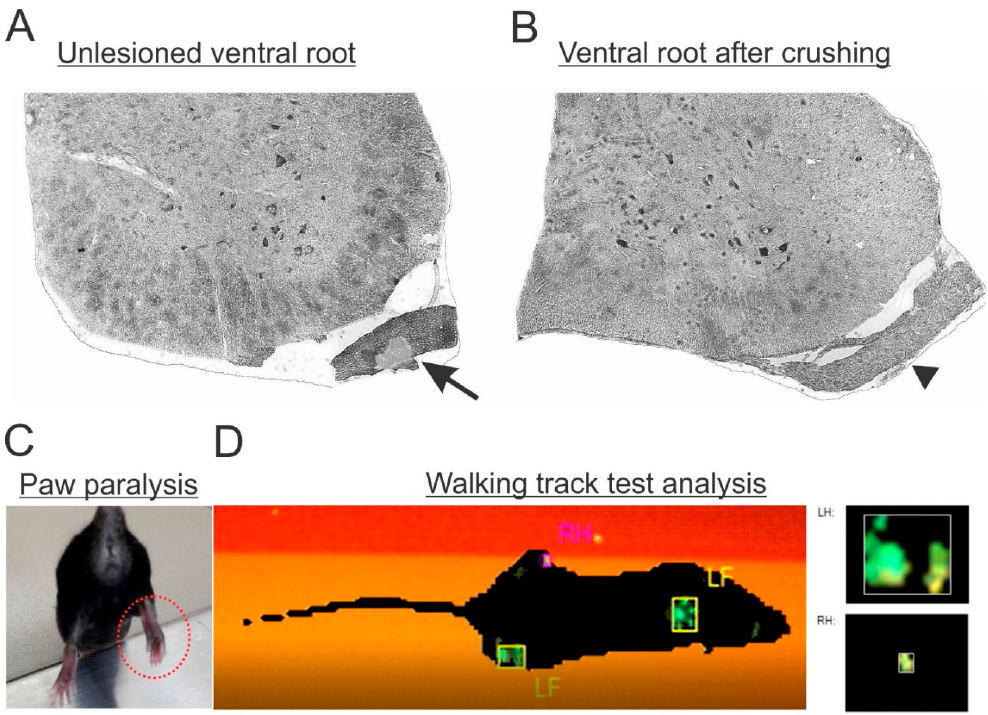
Figure 2. ( A ) Micrograph of a lumbar spinal cord transverse section showing the unlesioned ventral root morphology with intact axons (arrow). ( B ) Lesioned ventral root (arrowhead) with signs of ongoing Wallerian degeneration. ( C ) Paw paralysis behavior following L4, L5 and L6 ventral root lesion. Observe the adduction pattern of the toes combined with muscle atrophy (dotted red circle). ( D ) Gait analysis by the CatWalk system showing hindlimb loss of function ipsilateral to the lesion (RH).